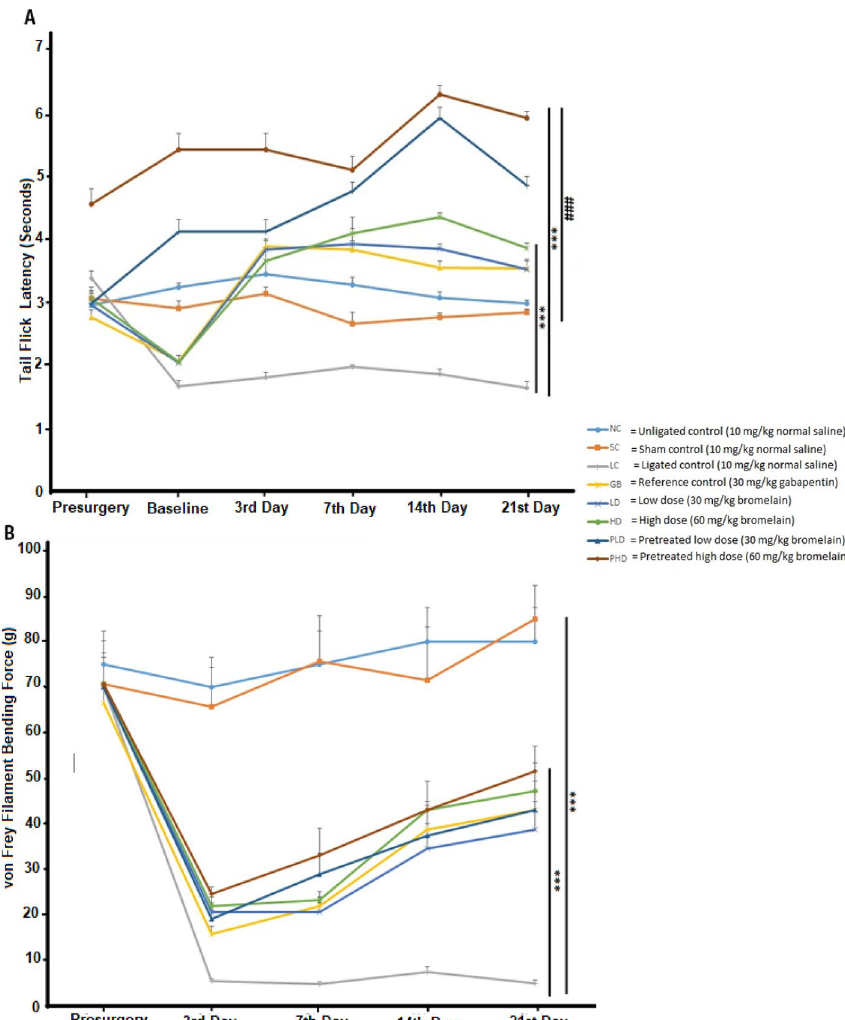
Figure 2. Bromelain reversed both thermal hyperalgesia and mechanical allodynia in sciatic nerve chronic constriction injury model of neuropathic pain. ( A ) Thermal hyperalgesia test. ( B ) Mechanical allodynia test. Each value represents the mean ± SEM of each group (n = 8). *Significant different (p < 0.05) compared with ligated control, # significant different (p < 0.05) compared with unligated